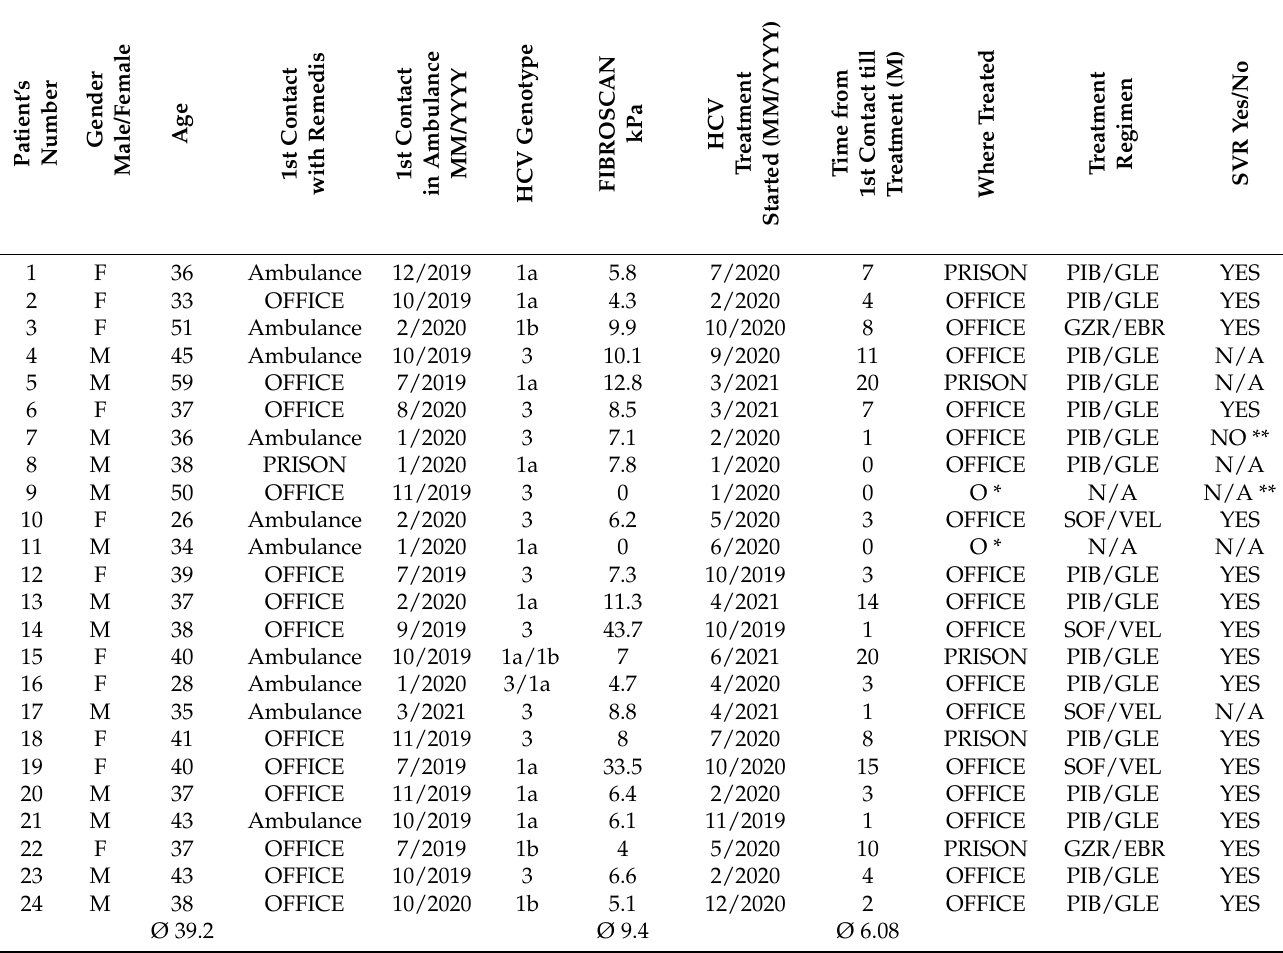
Table 3. PWID clients recruited in the outreach program who successfully started DAA treatment.